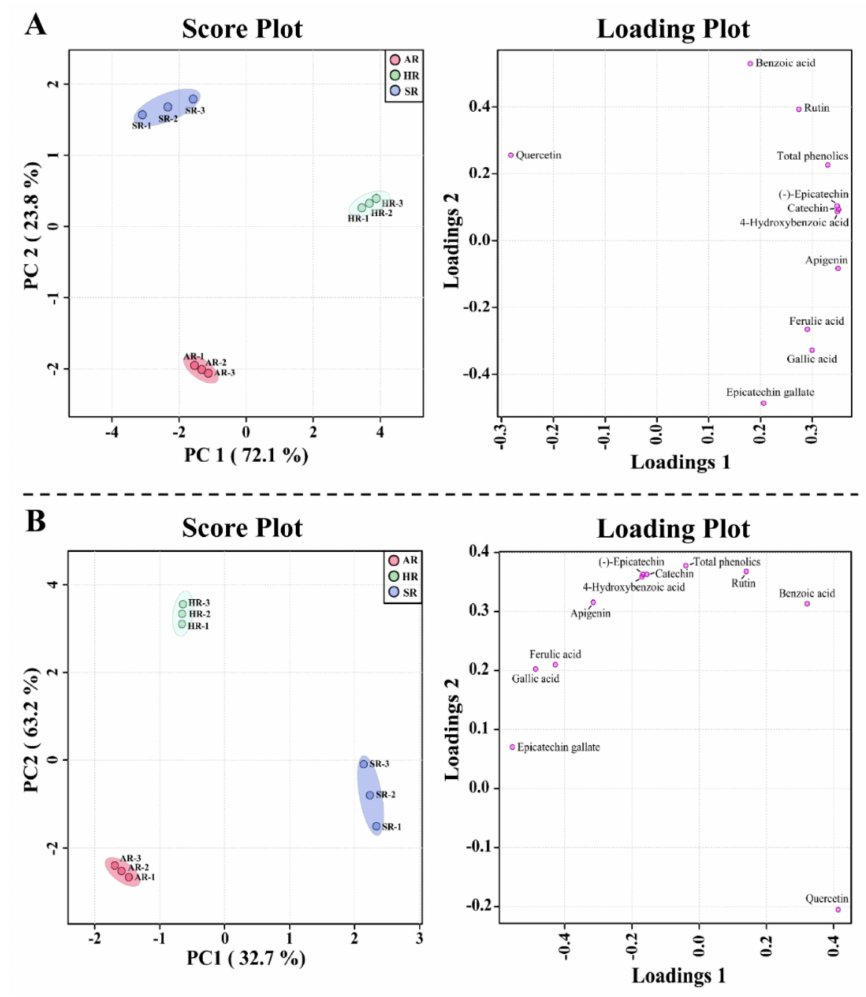
Figure 4. Score and loading plot of ( A ) PCA model and ( B ) PLS-DA model obtained from the metabolites detected in different root cultures of F. tataricum